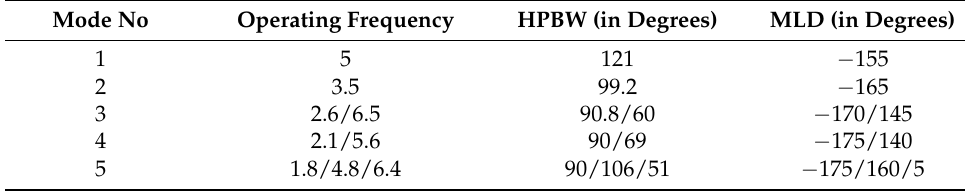
Table 3. Summary of half power beamwidth and main lobe direction.